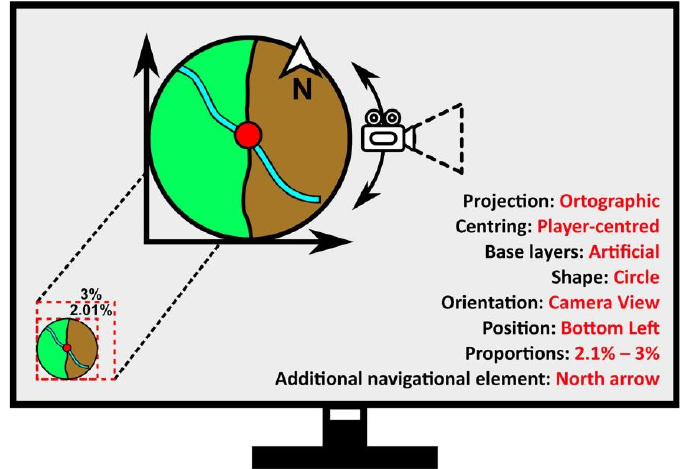
Figure 4. Mini-map composition on the display view (16:9) with the most popular parameters of 8 design features—by separate analysis for each parameter.